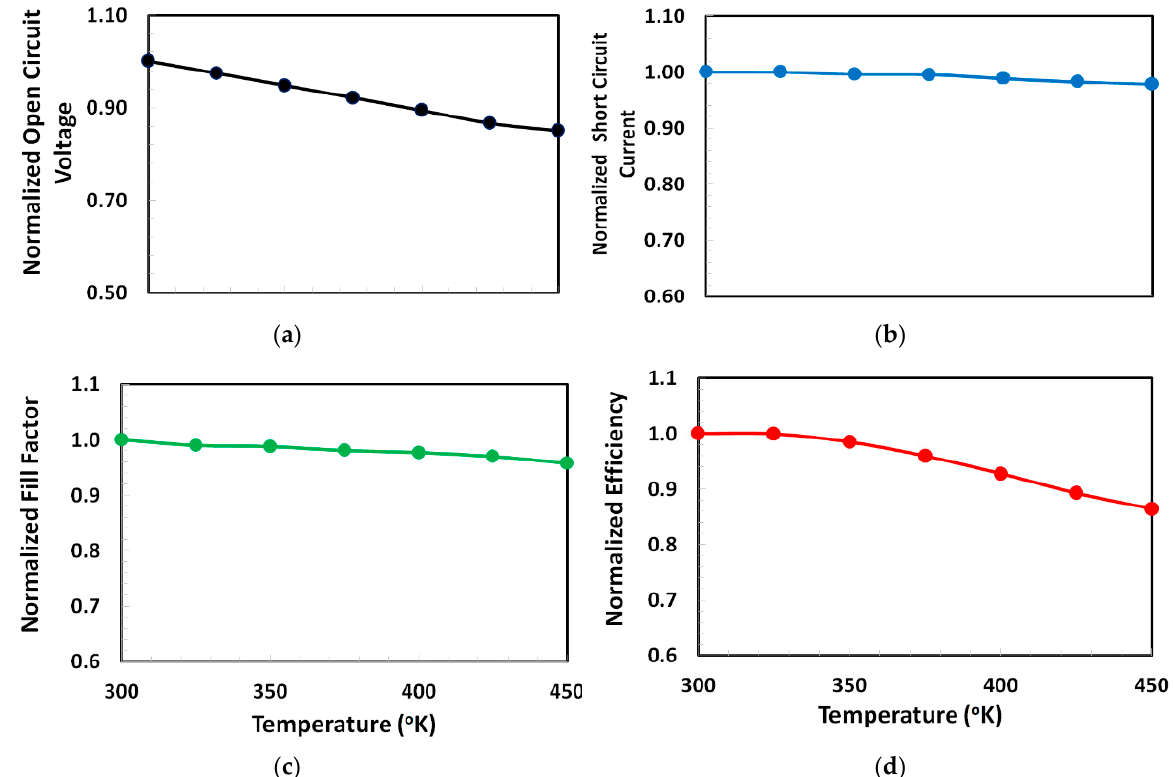
Figure 7. Degradation response of ( a ) normalized open-circuit voltage, ( b ) normalized short-circuit current, ( c ) normalized fill-factor, and ( d ) normalized power-conversion efficiency of the proposed solar cell Ag/BCP/PCBM/Cs 2 TiBr 6 /NPB/ITO as a function of ambient temperature varied from 300 to 450 °K.